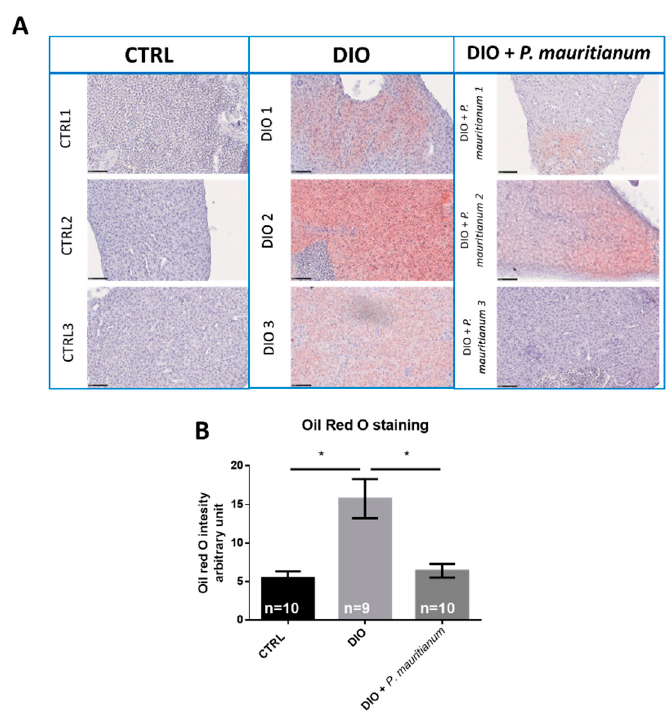
Figure 6. The aqueous extract of P. mauritianum prevents lipid accumulation in the liver of adult DIO fish. ( A ) Liver sections stained with ORO in three representative individual control fish (CTRL 1 to 3), three individual DIO fish (1 to 3) and three individual DIO fish treated with P. mauritianum (0.25 g/L; 1 to 3), showing no lipid accumulation, heterogeneous lipid (red) accumulation and low lipid accumulation (faint red), respectively, after the 4 th week of the feeding protocol. ( B ) Red color intensity quantification using ImageJ quantification for mean red color intensity on the liver sections of CTRL, DIO and DIO treated with P. mauritianum. n = 9–10, number of fish. Bar graph: standard error of the mean (SEM). One-way ANOVA: * p < 0.05. Bar: 100 μ m.